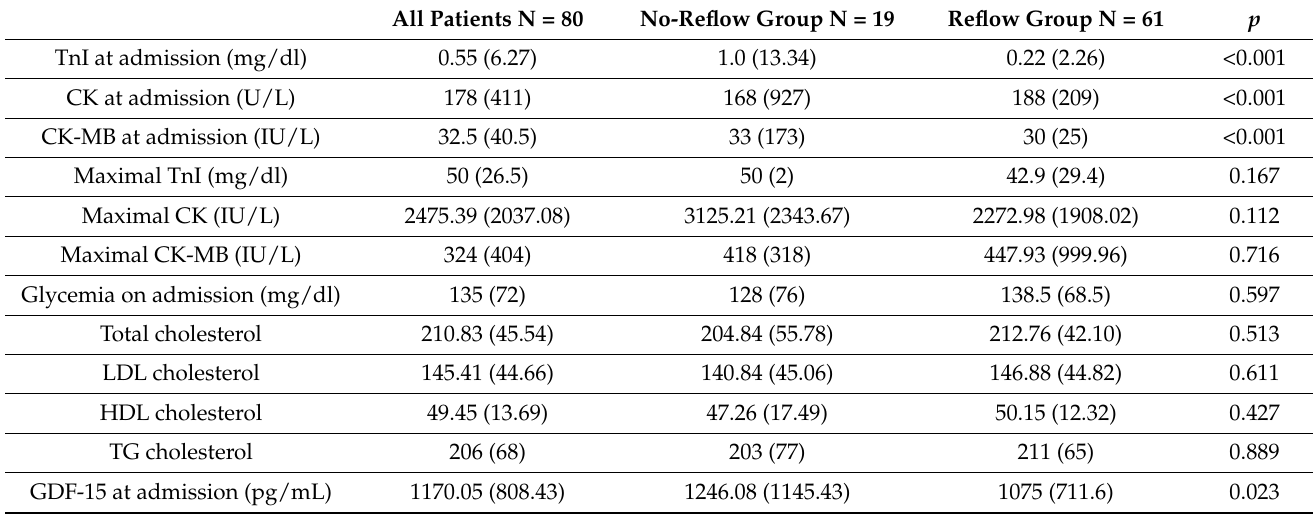
Table 1. Biochemical characteristics.